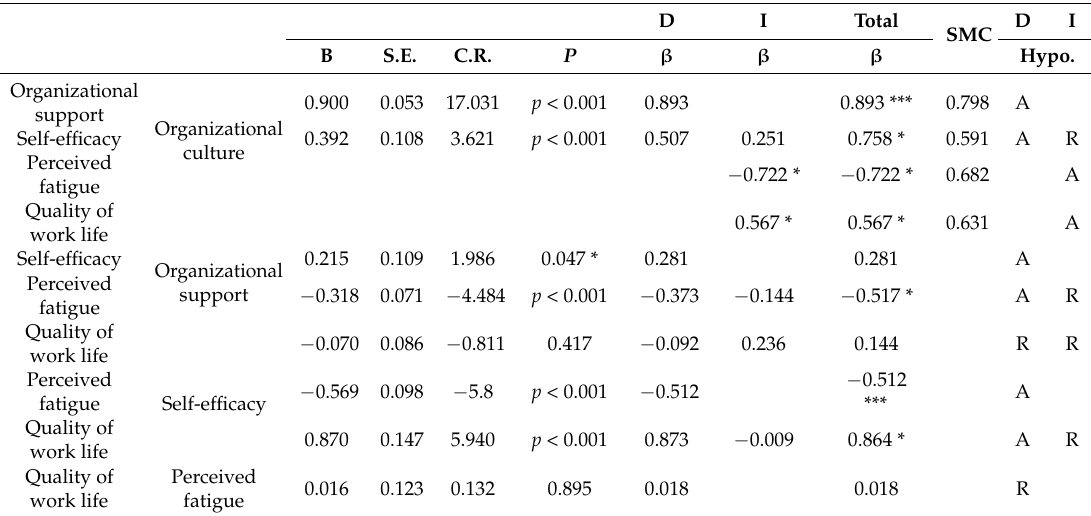
Table 2. Parameter Estimation Results of the Structural Model.